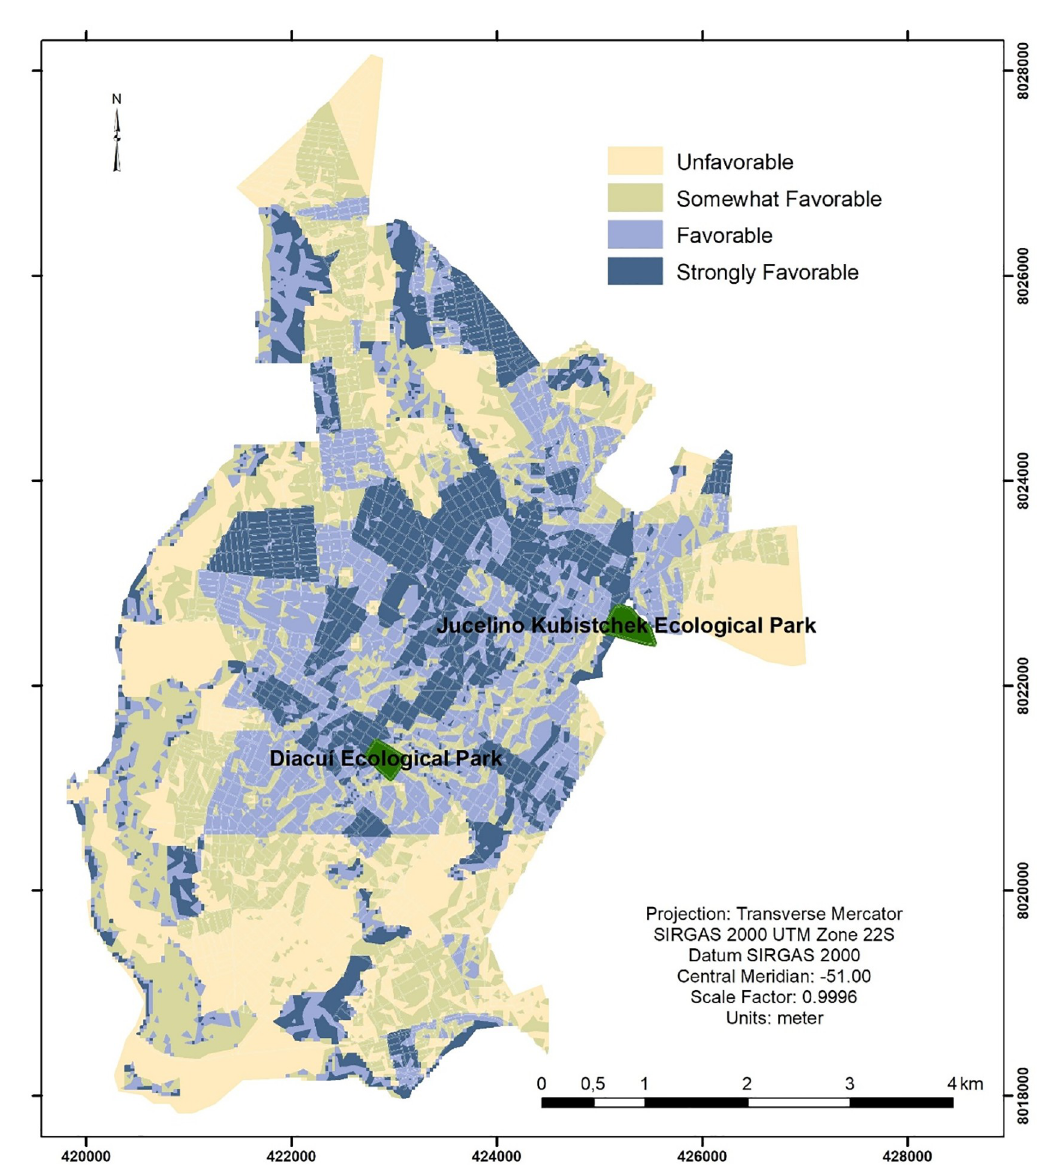
Fig 1. Classification of urban environment ability to promote physical activity according to spatial and demographical characteristics. Cartographical output produced by the authors, with original content modelled from open-access information not requiring license, permission and copyright